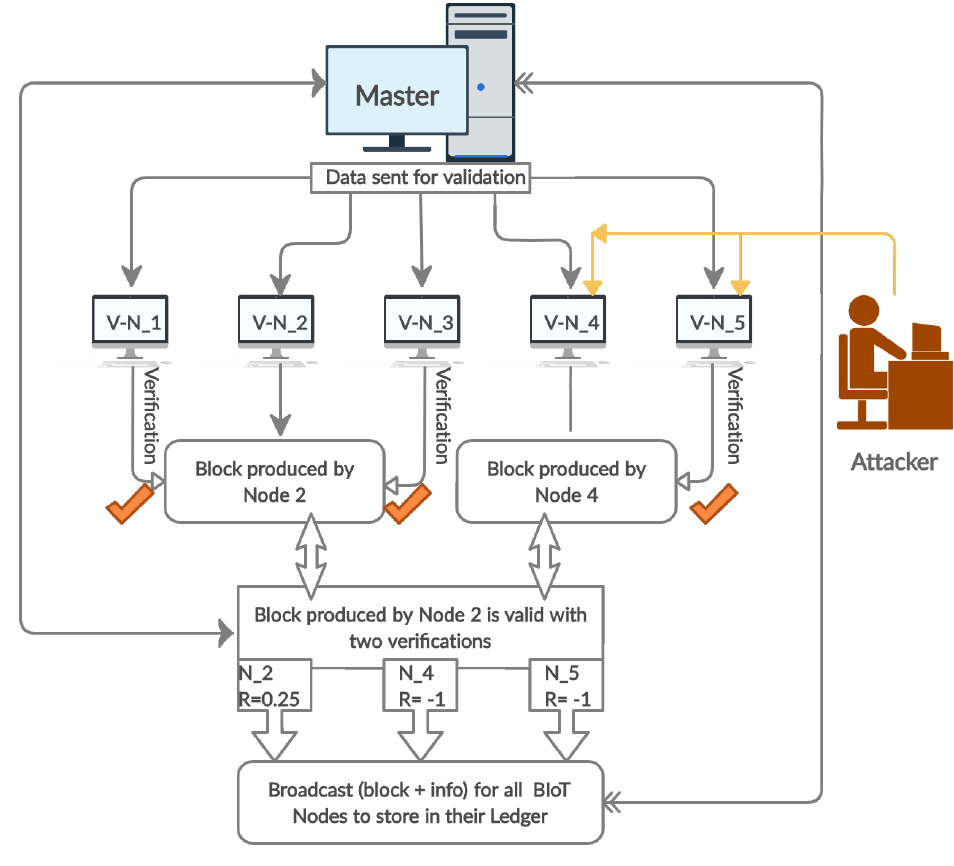
Figure 9. Case study for blockchain